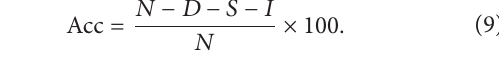
the adaptation data, which is shown on each of the